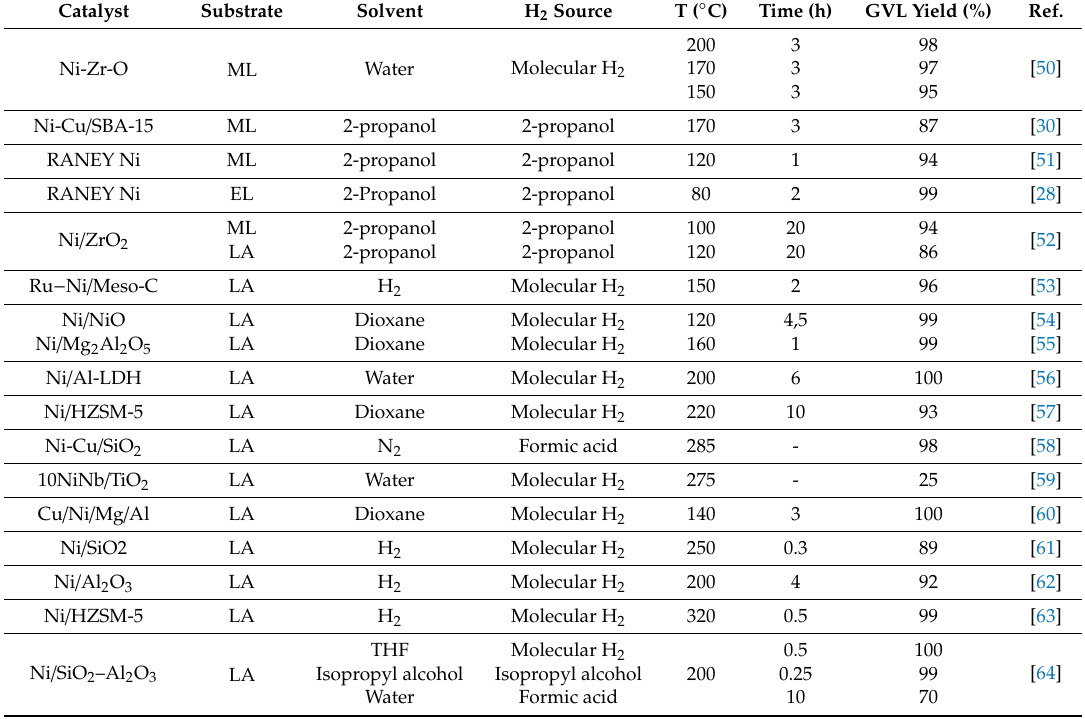
Table 1. Overview of Ni catalysts for GVL synthesis from methyl levulinate (ML), ethyl levulinate (EL) and levulinic acid (LA).